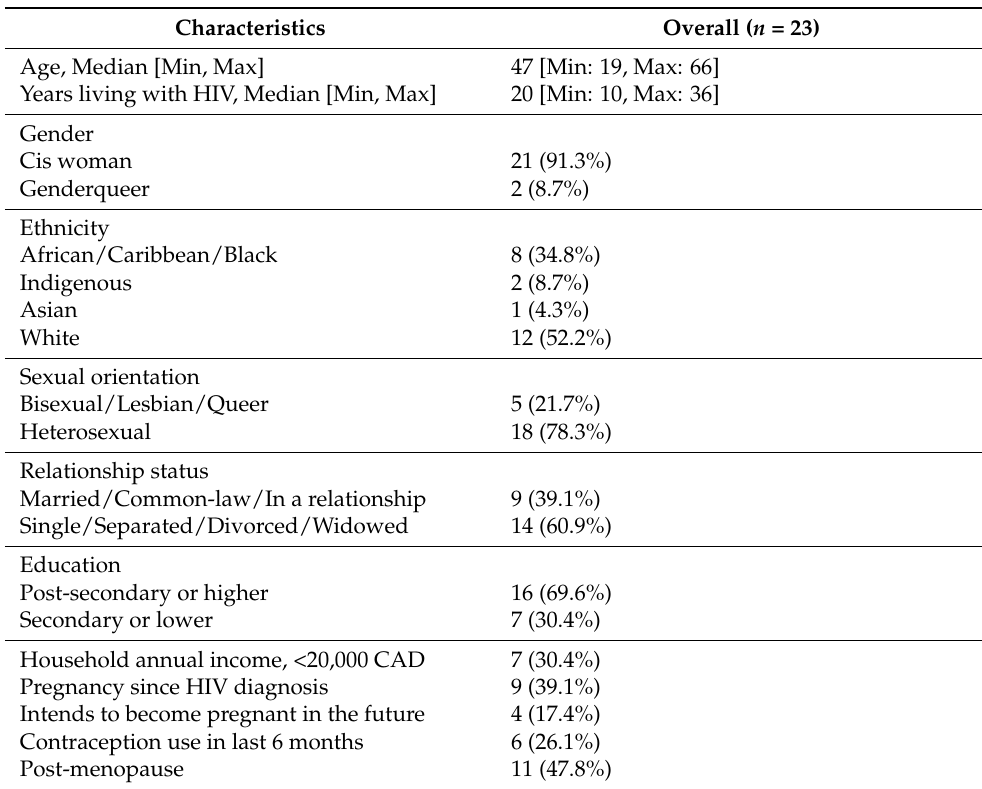
Table 1. Participant